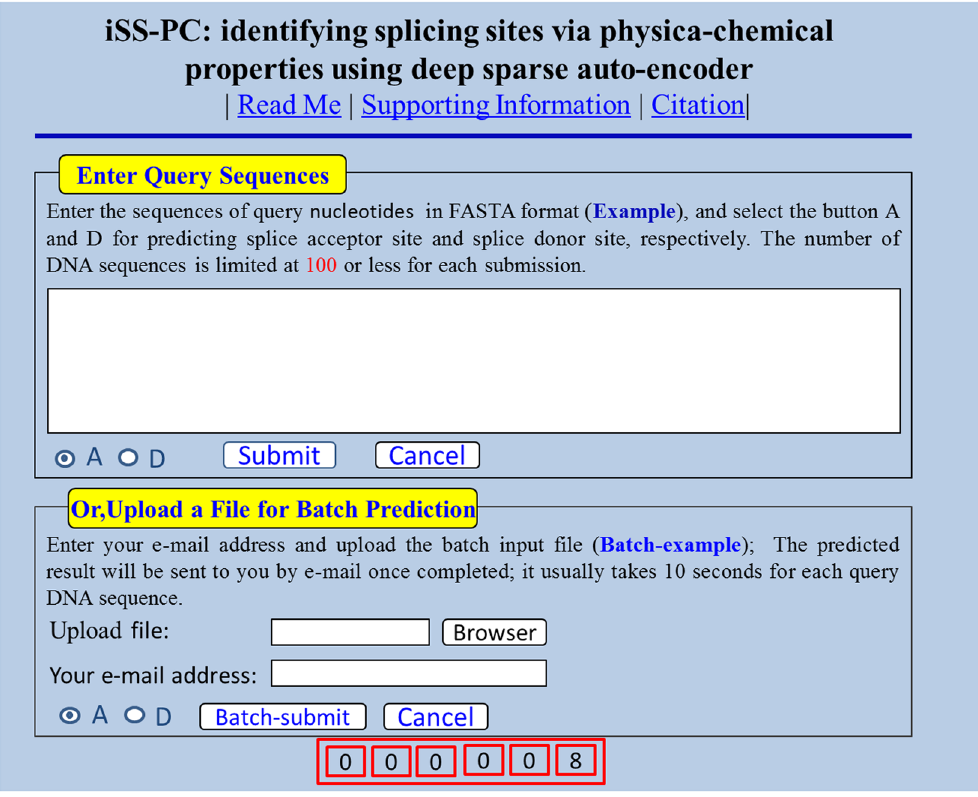
Figure 5. A semi-screenshot of the homepage for the web-server